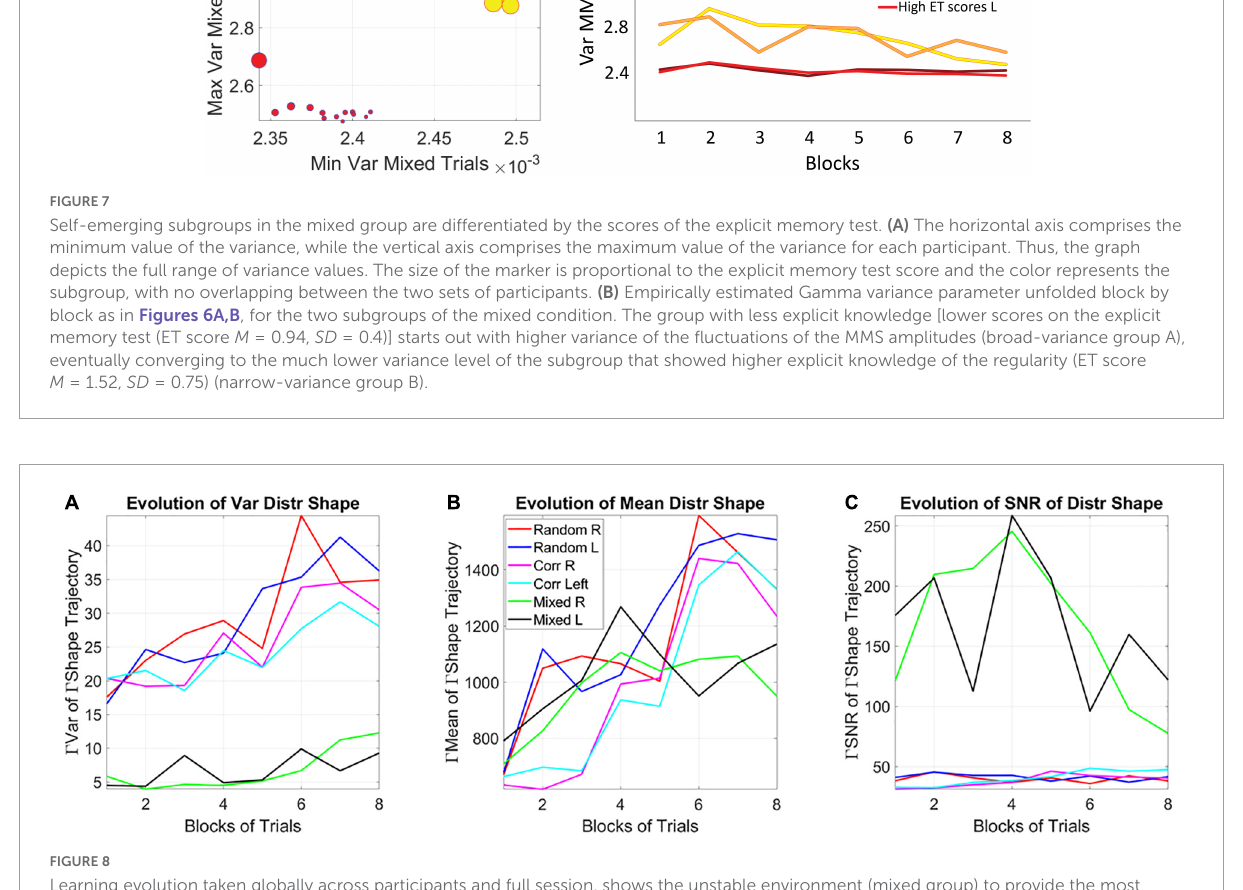
Figure 9F focuses on the error correction process. Here we see the opposite trend whereby initially the distributions have symmetric shape (in the Gaussian range of the Gamma family) but as time progresses, the distribution shapes approach values closer to those observed for the exploratory process: skewed, heavy tailed